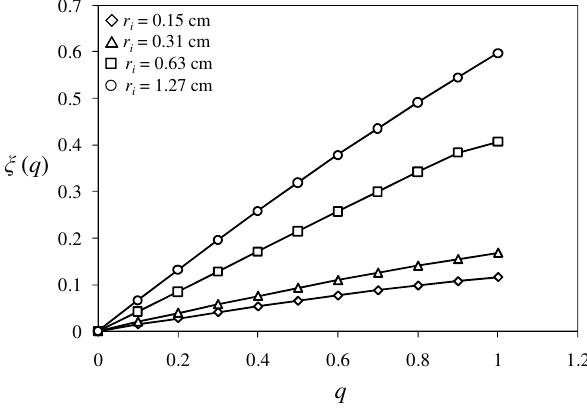
Fig. 10. ESS estimates of ξ(q) versus q evaluated on face 1 in x direction and various r i